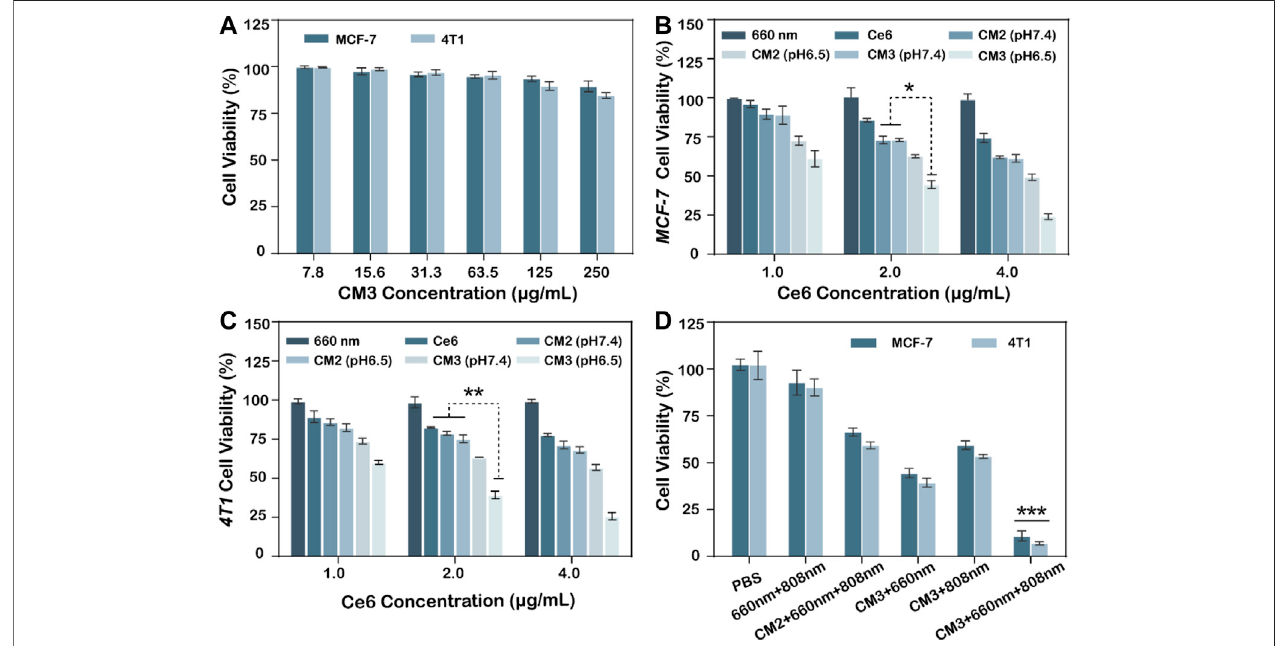
FIGURE 5 | (A) Viability of MCF-7, 4T1 cells after treating with different concentrations of Ce6-PLGA@PDA-PAH-DMMA (CM3) without lasers. Viability of MCF-7 cells (B) and 4T1 cells (C) after incubation with Ce6-PLGA@PDA-PEG NPs (CM2) and Ce6-PLGA@PDA-PAH-DMMA NPs (CM3) at concentrations of Ce6 (1.0 μ g/ml, 2.0 μ g/ml,and4.0 μ g/ml)underthe660-nmlaserirradiation(200 mW/cm 2 ,5 min)atpH6.5. (D) ViabilityofcancercellsafterPTTorPDTaloneandPTT/PDTtreatments ( t -test, * p < 0.05, ** p < 0.01, *** p < 0.001 and n = 3); Q value method: Q = V (a + b)/(Va + Vb — Va* Vb). V (a + b) is the inhibition rate of combined A and B drug, Va and Vb are the A and B drugs alone (Q < 0.85 is antagonism, 0.85 ≤ Q < 1.15 is additive, and Q ≥ 1.15 is synergy).